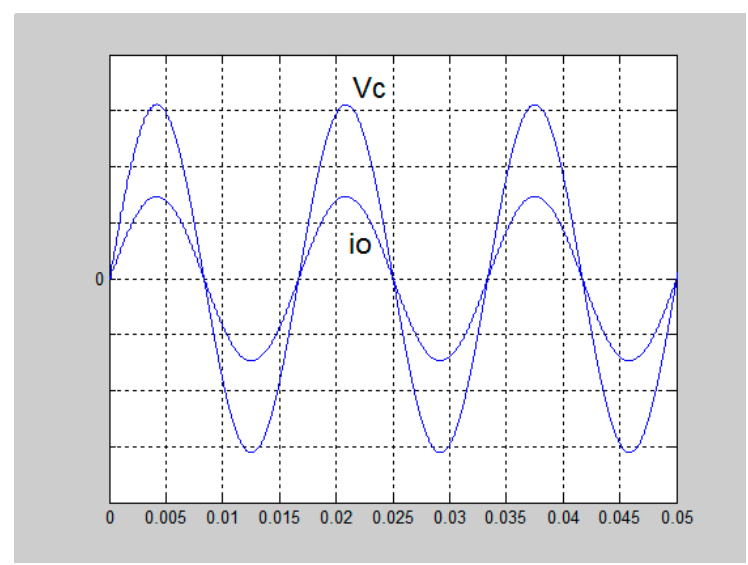
Figure 4. Simulated waveform under LC (inductor capacitor) variation for the improved technique (50 V/div; 10 A/div).